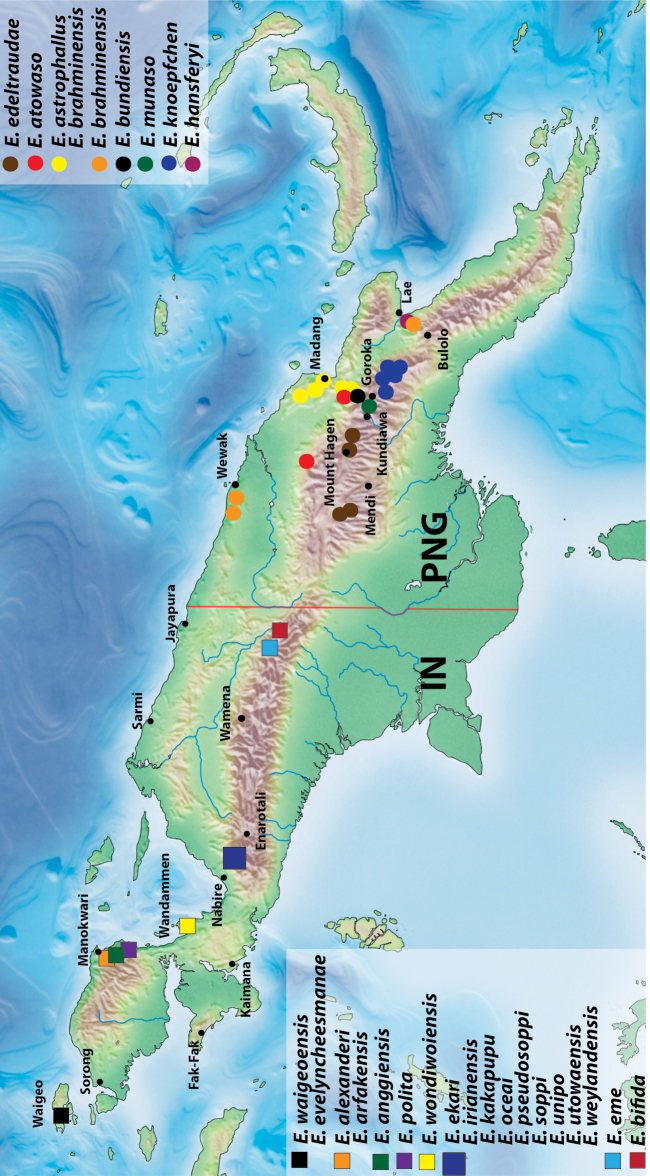
Map of New Guinea showing distribution of the species of the Exocelina ekari-group.